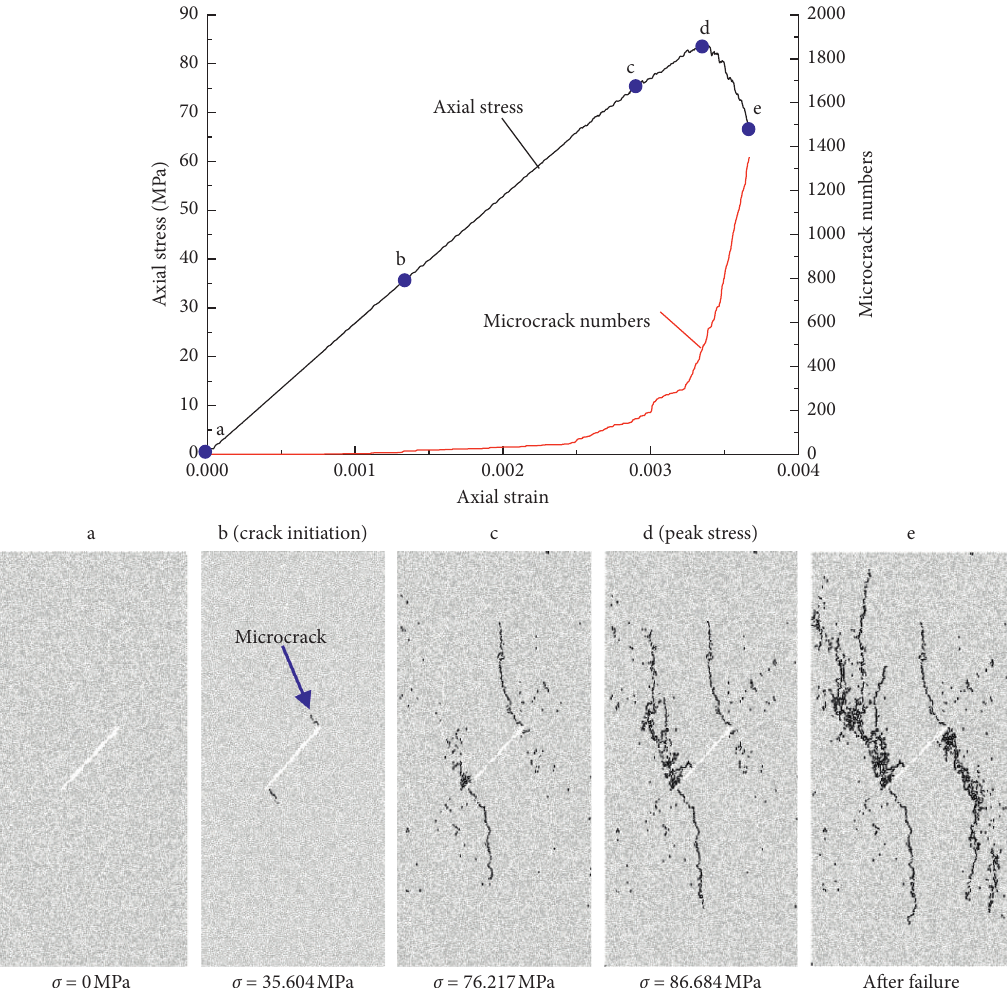
Figure 4: Crack initiation, propagation, and coalescence processes of the numerical model for granite specimen ( α � 45 ° and β � 0 ° ).